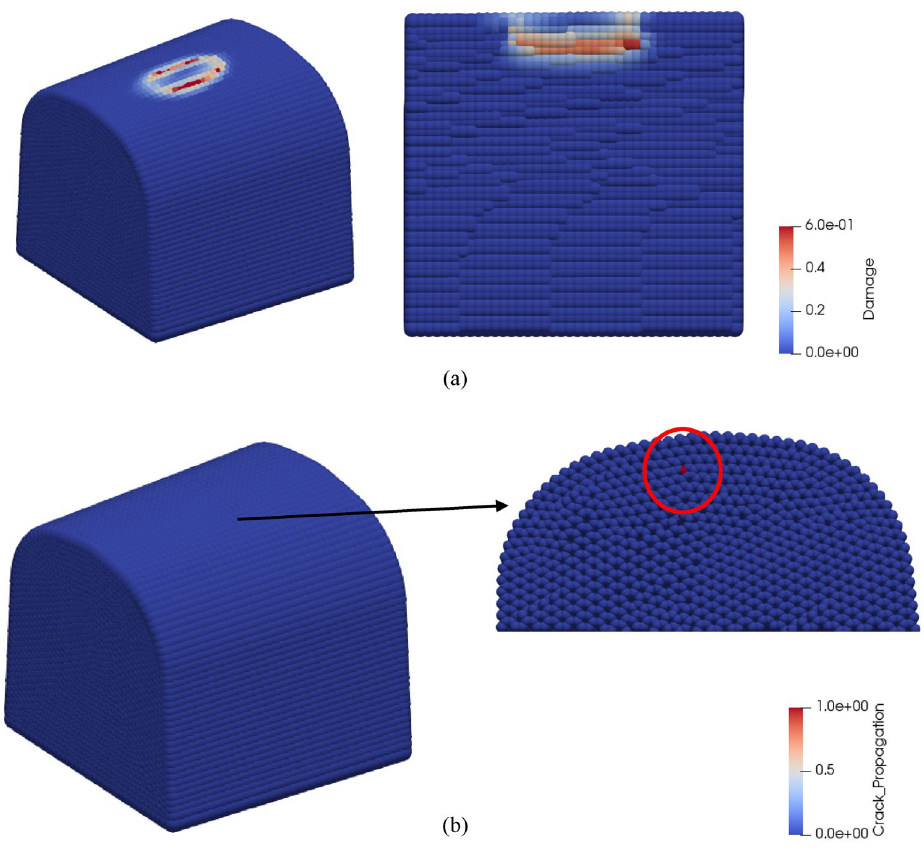
Figure 15. ( a ) Damage values over contact patch when a crack develops. ( b ) A cross-section of crossing nose that shows crack